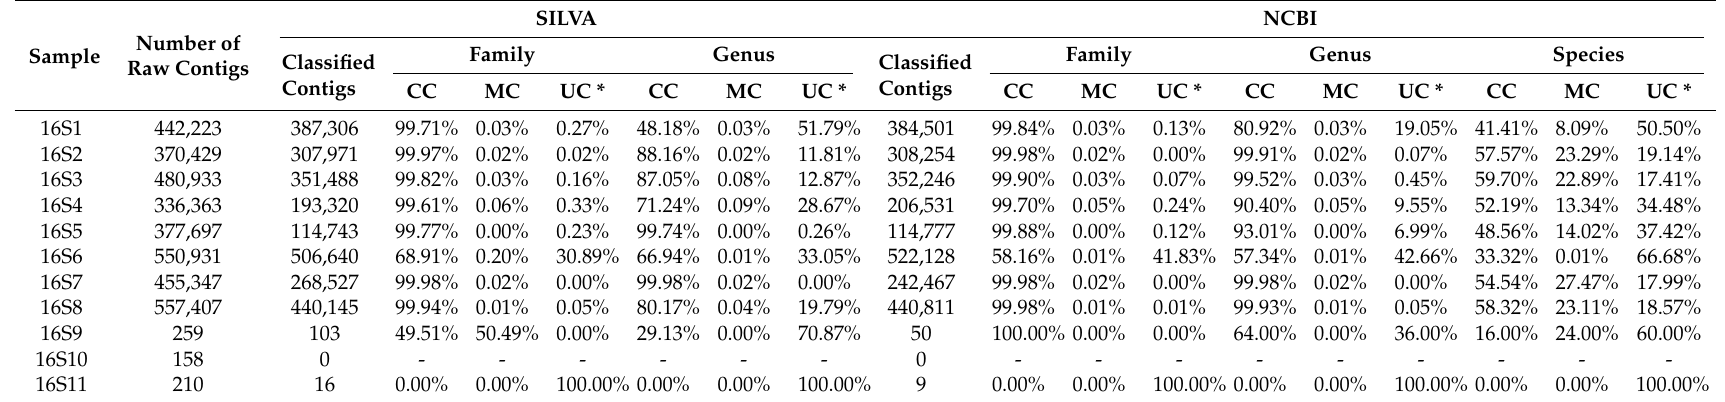
Table 2. Classification results for MiSeq data for the different gene regions and taxonomic levels using the SILVA and NCBI 16S databases. Read numbers are expressed as